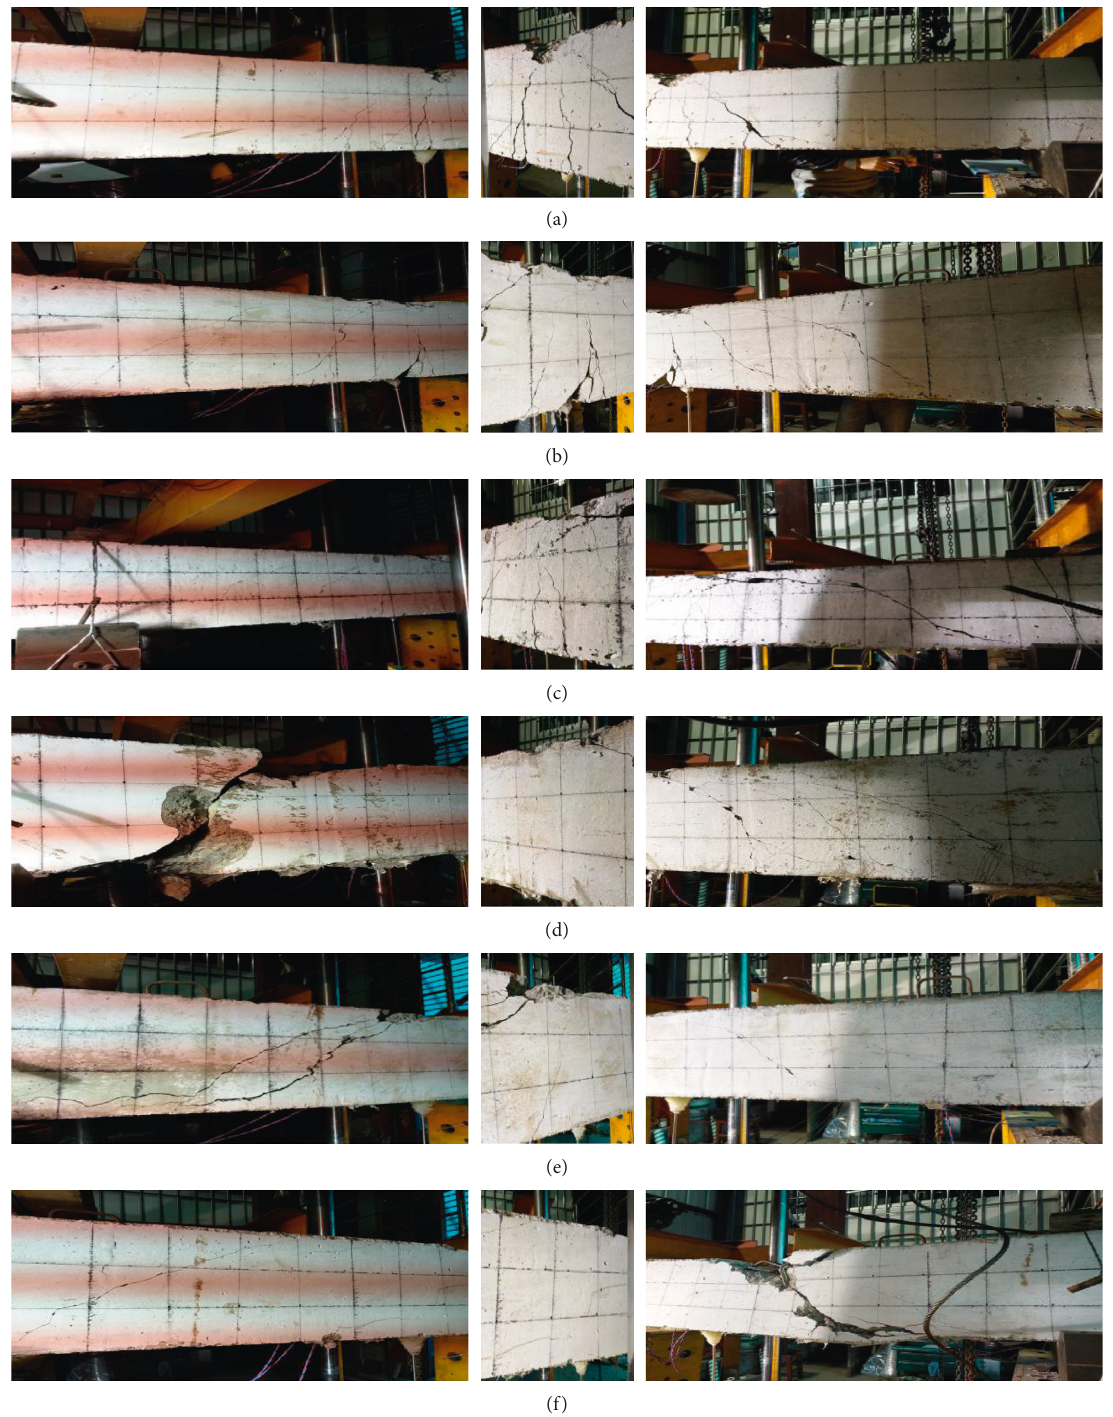
Figure 15: Beam failure form. (a) L18. (b) S12. (c) L20. (d) S16. (e) L25. (f)